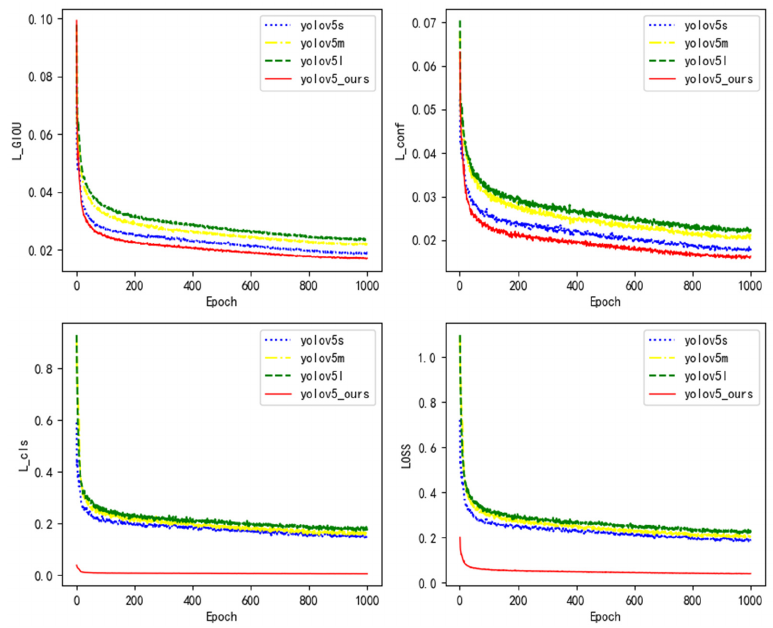
Figure 14. The convergence curve of the loss function for different YOLO models.